Question: Condense the content of this figure into a single sentence.
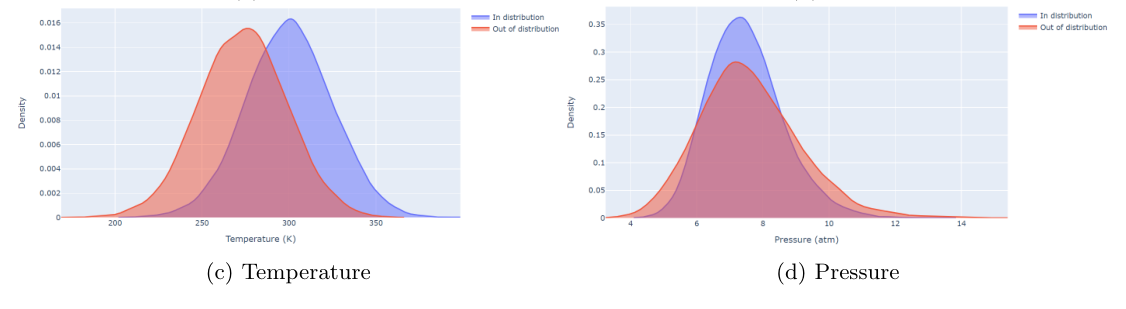
Answer: Distribution of Volume, Moles, Temperature, and the resulting calculated Pressure for the train (”in distribution”) vs. test (”out-of-distribution”) datasets